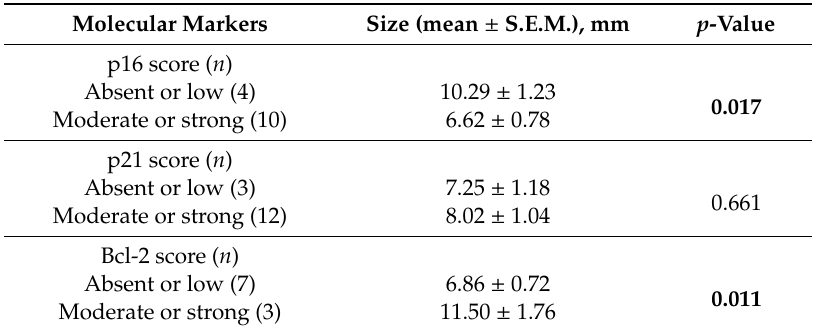
Figure 2. Representation of the final score estimation in the immunoexpression profiling: ( A ) Results of the immunoexpression profiling classified in absent or low staining and moderate or strong staining categories for p16, p21, Bcl-2, Raf kinase inhibitor protein (RKIP), and cyclin-dependent kinase D1 (Cyclin D1); and ( B ) Median size of the appendiceal NENs according to the molecular markers’ staining score, (bars with s.e.m., * p < 0.05). Table 2. Molecular markers expression and tumor size association. Values in bold are statistically significant, p <